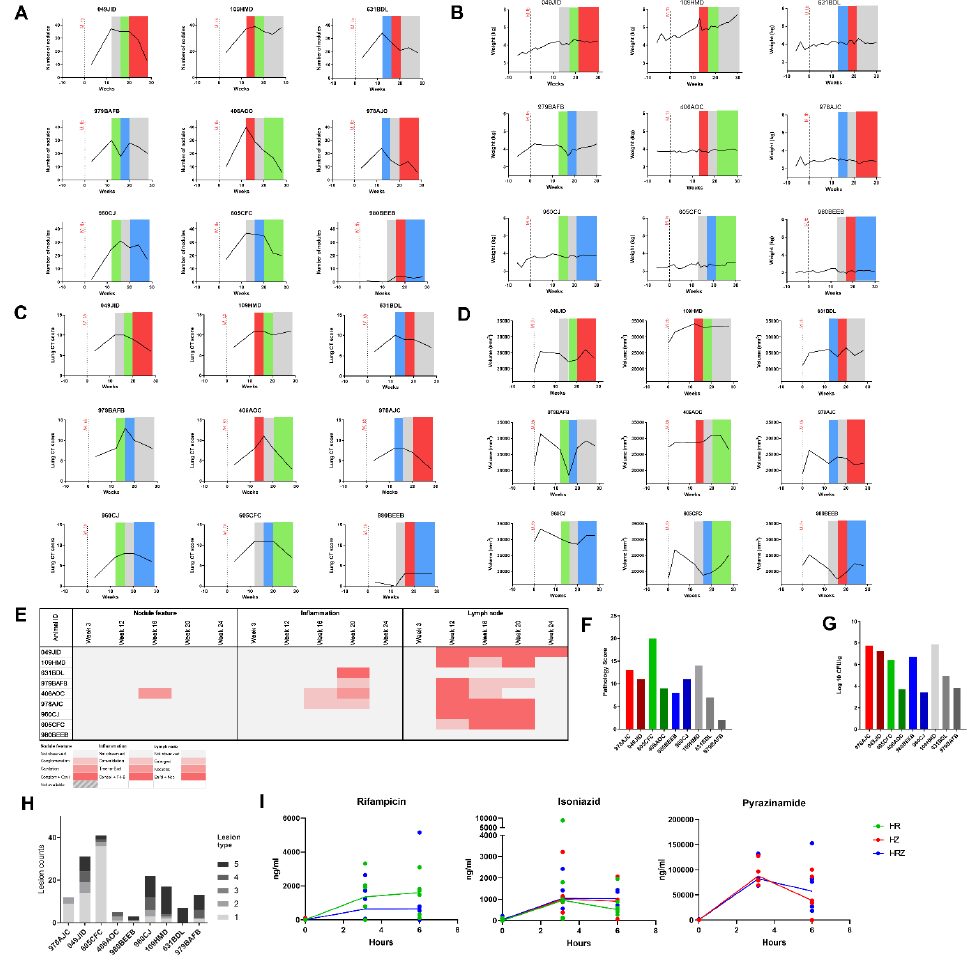
Figure 3 . Measures of M. tb induced disease burden and drug exposure levels in blood from cynomolgus macaques following infection with M. tb H37Rv over three phases of treatment with combinations of HR, HZ or HRZ. ( A ) Pulmonary nodule counts measured from CT scans, ( B ) body weight profiles, ( C ) lung scores measured by CT, ( D ) volume of diseased lung measured from CT scans, ( E ) heat map of disease characteristics observed from CT scans, ( F ) gross pathology scores, ( G ) summed M. tb bacillary burden (CFU) cultured from extrapulmonary tissues, ( H ) pulmonary granuloma lesion numbers and types quantified during histopathology evaluation, ( I ) levels of Rifampicin, Isoniazid and Pyrazinamide detected in blood samples collected 3.15 and 6 h after administration, ng/mL. Red = HZ, green = HR, blue = HRZ, gray = no treatment. Twelve weeks after M. tb challenge, animals were randomly assigned to one of nine sequences of four treatments (No treatment, Isoniazid and Rifampicin (HR), Isoniazid and Pyrazinamide (HZ) and Isoniazid, Rifampicin and Pyrazinamide (HRZ)). During the treatment phases, body weights generally remained stable or increased and nodule